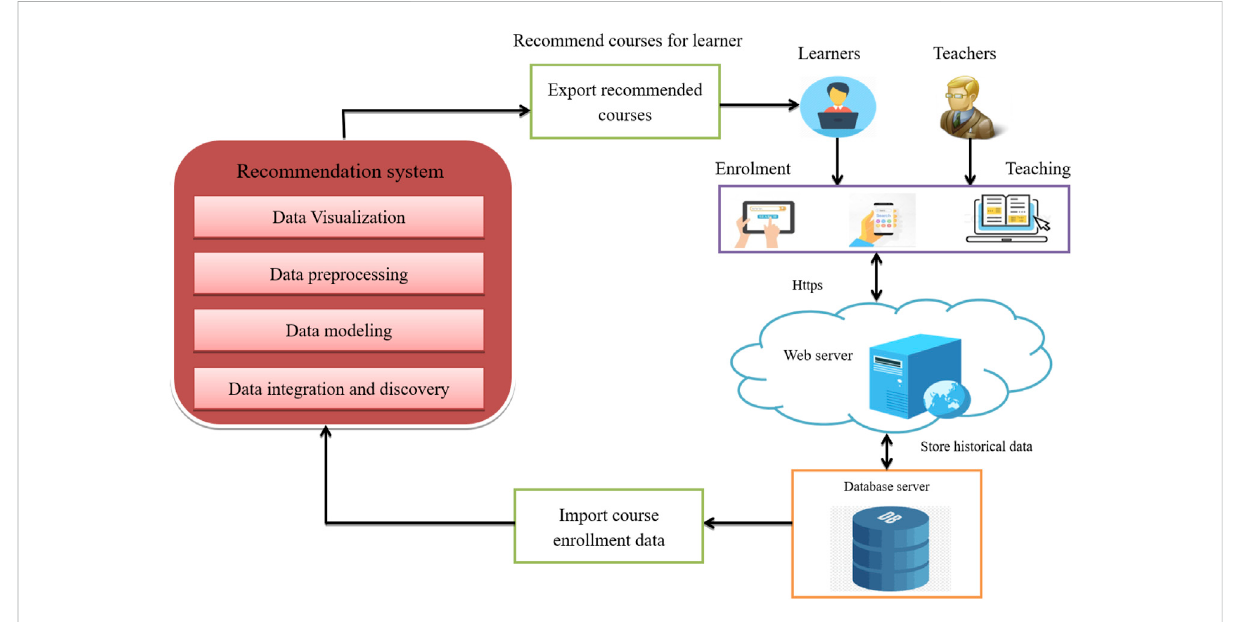
FIGURE 4 The proposed big data analytics in online learning.